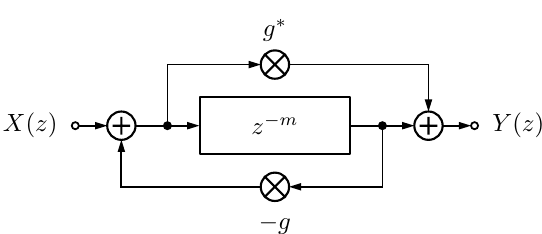
Figure 1. Classic Schroeder allpass filter [1], i.e., a feedforward–feedback delay filter.